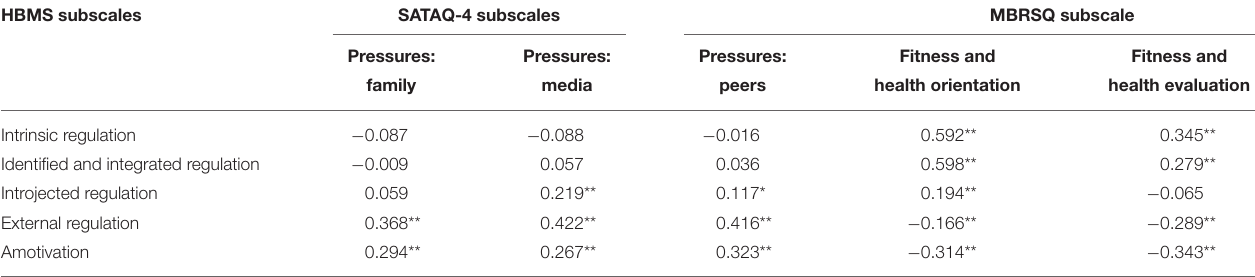
TABLE 7 | Pearson’s correlation coefficients between the health behavior motivation scale (HBMS) subscales and different dimension of SATAQ-4 and MBRSQ, Study